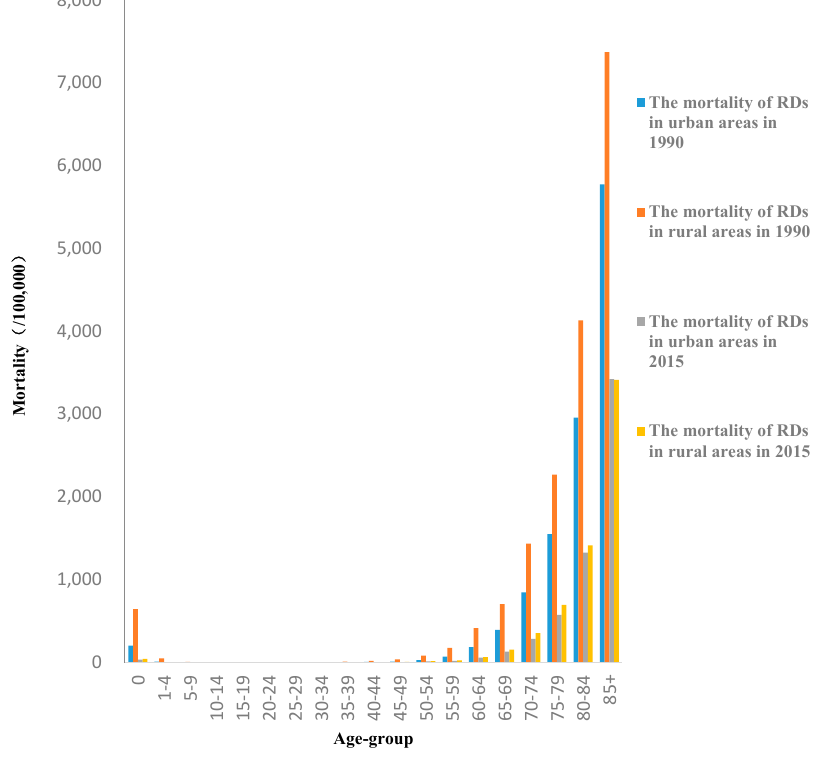
Figure 3. The age-specific mortality rates of RDs in urban and rural areas in 1990 and 2015.